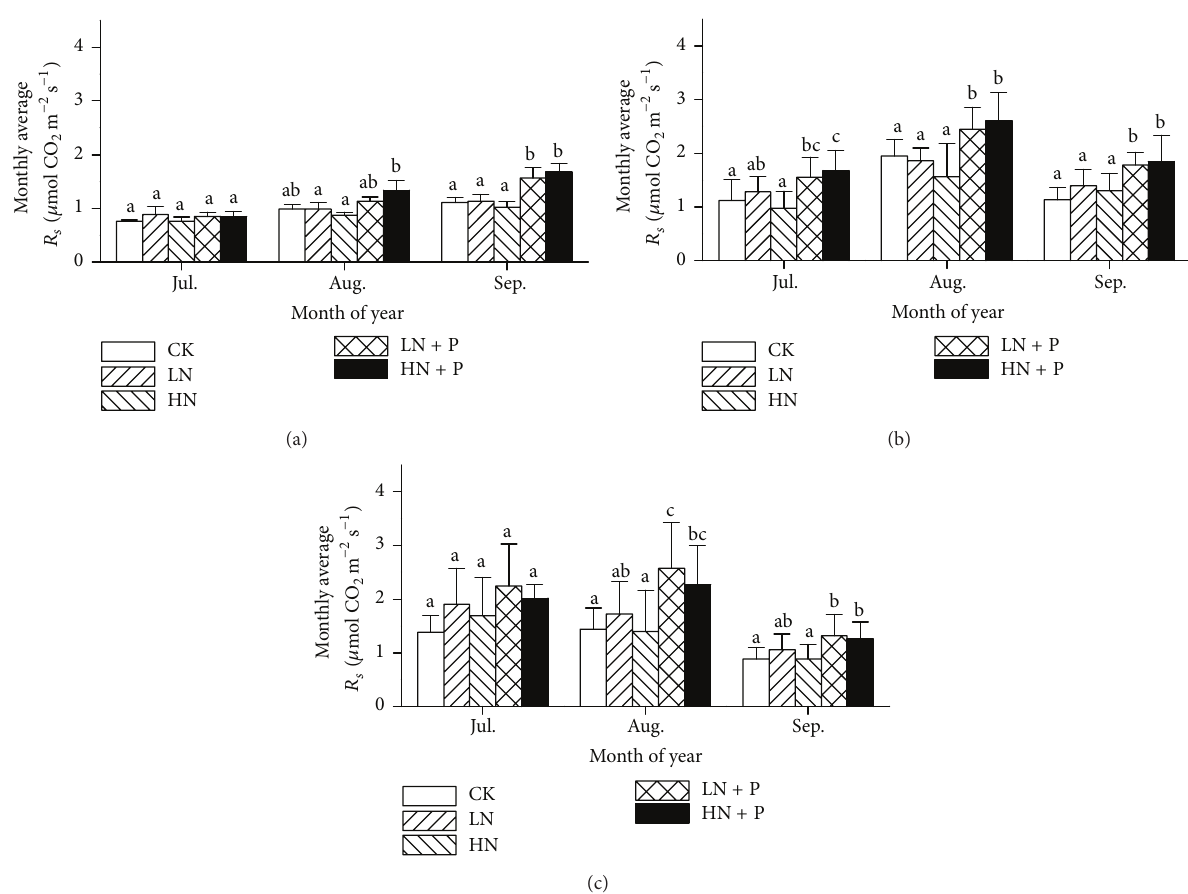
Figure 5: Monthly mean values of soil respiration during the 2010, 2011, and 2012 growing seasons. Bars sharing the same letters indicate no significant difference at P < 0.05 significant level. See Figure 1 for